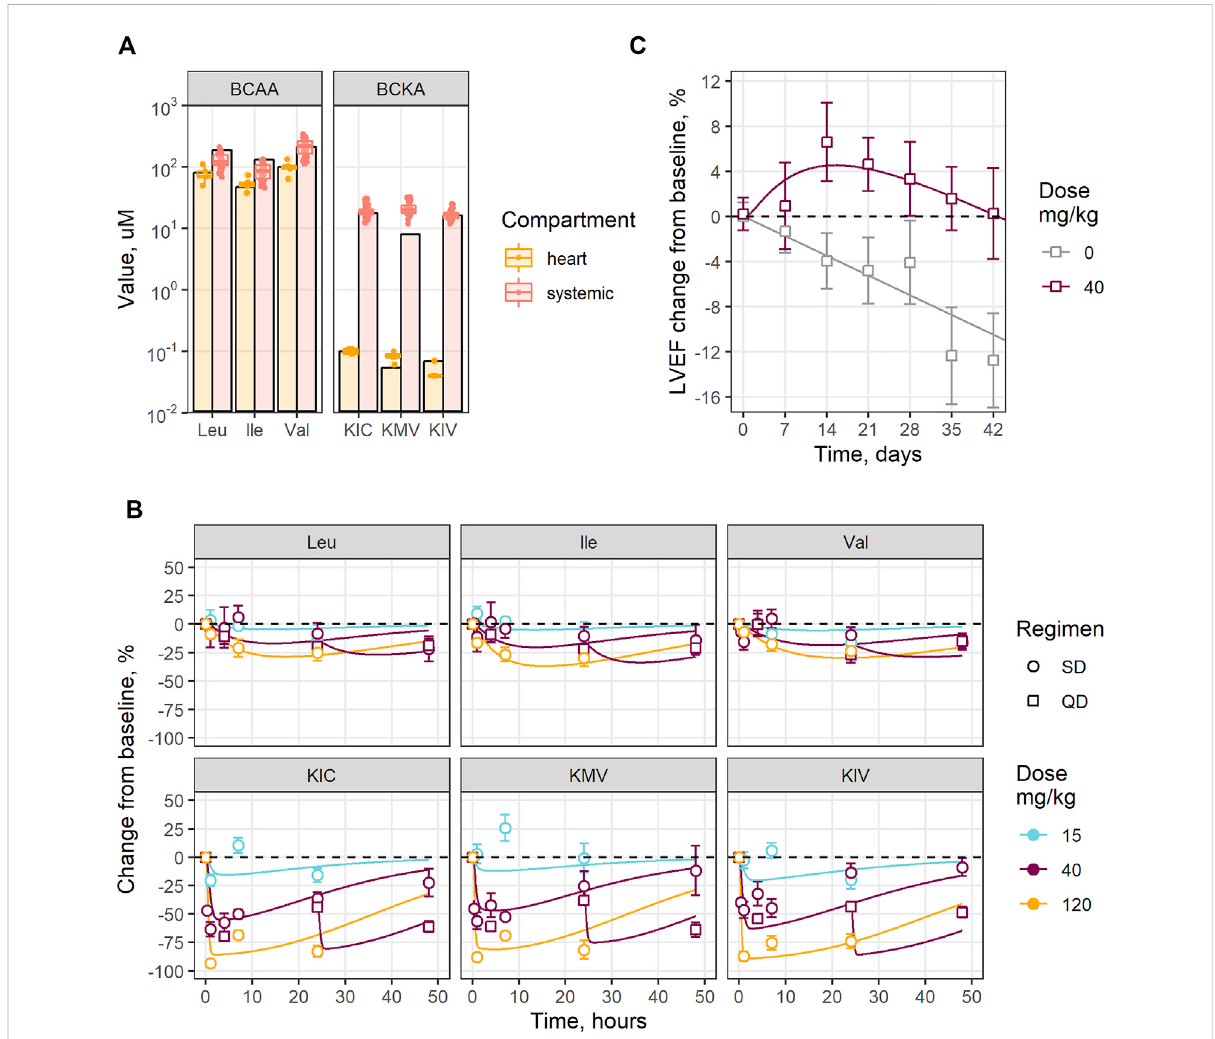
FIGURE 2 Experimental data reproduction by the model: (A) Steady-state BCAA and BCKA levels; (B) Change over time in plasma BCAA and BCKA levels underdifferentBT2dosesandregimens(SD — singledose,QD — oncedaily); (C) LVEFchangeinmouseafterTACsurgery,treatedwithvehicleorBT2. Circles, squares and error bars — observed mean values and standard errors, lines — model predictions; dots — individual measurements in plasma, bars — model